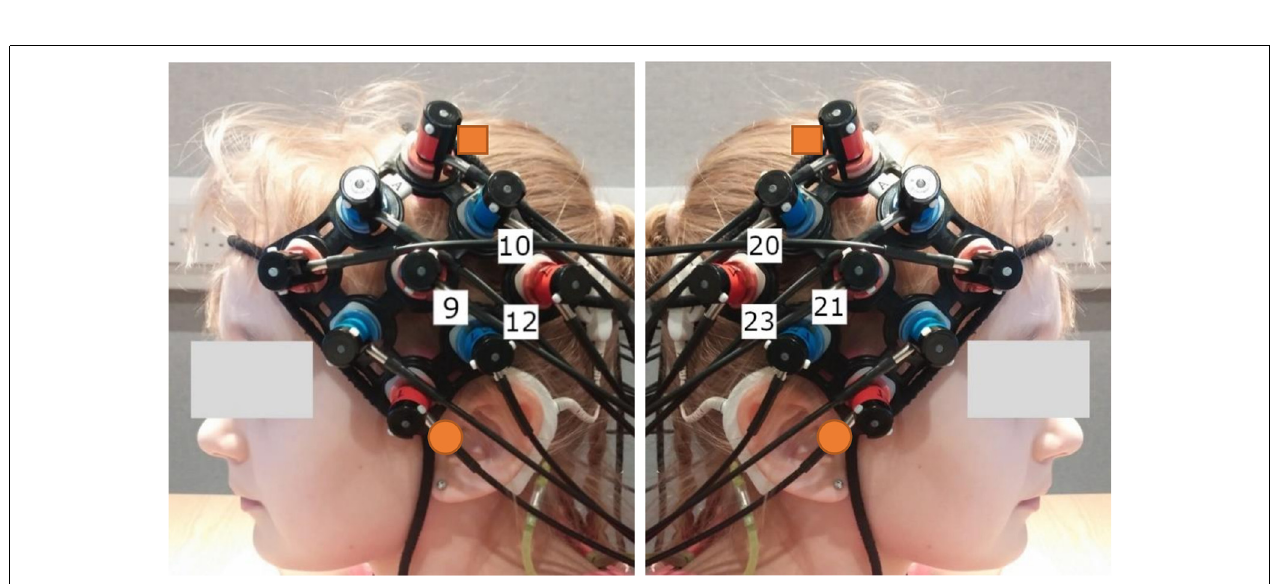
FIGURE 3 | Typical optode array placement and approximate location of the channels forming the Region of Interest (ROI). The orange squares indicate point Cz and the orange circles indicate the preauricular point, as taken from the International 10-20 system (Jasper, 1958) to guide array placement. The ROI was selected to cover temporal brain regions bilaterally. Channels 9, 10, and 12 targeted the left hemisphere (LH) and channels 20, 21, and 23 targeted the right hemisphere (RH).